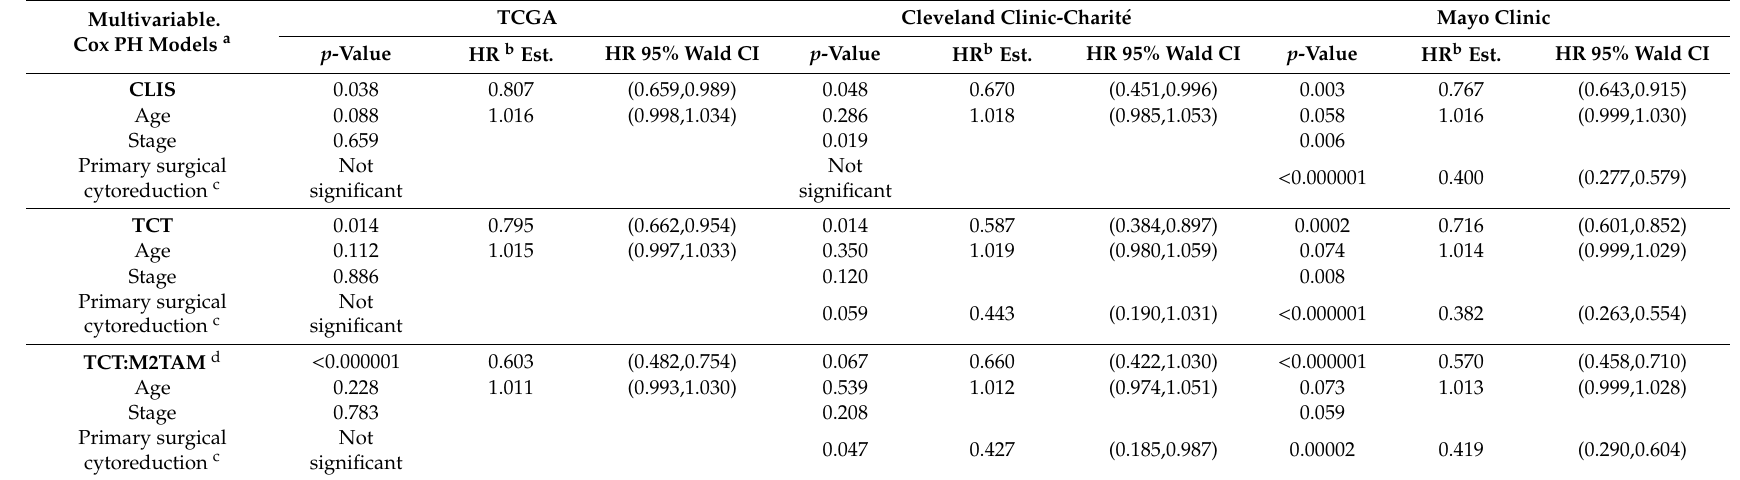
Table 2. Multivariable Cox proportional hazards (PH) model results for overall survival (OS) using immune signatures Cytotoxic Lymphocyte Immune Signature (CLIS), T cell tra ffi cking (TCT), T cell tra ffi cking:M2 tumor associated macrophages (TCT:M2TAM) signatures from three independent high-grade serous ovarian cancer (HGSOC)